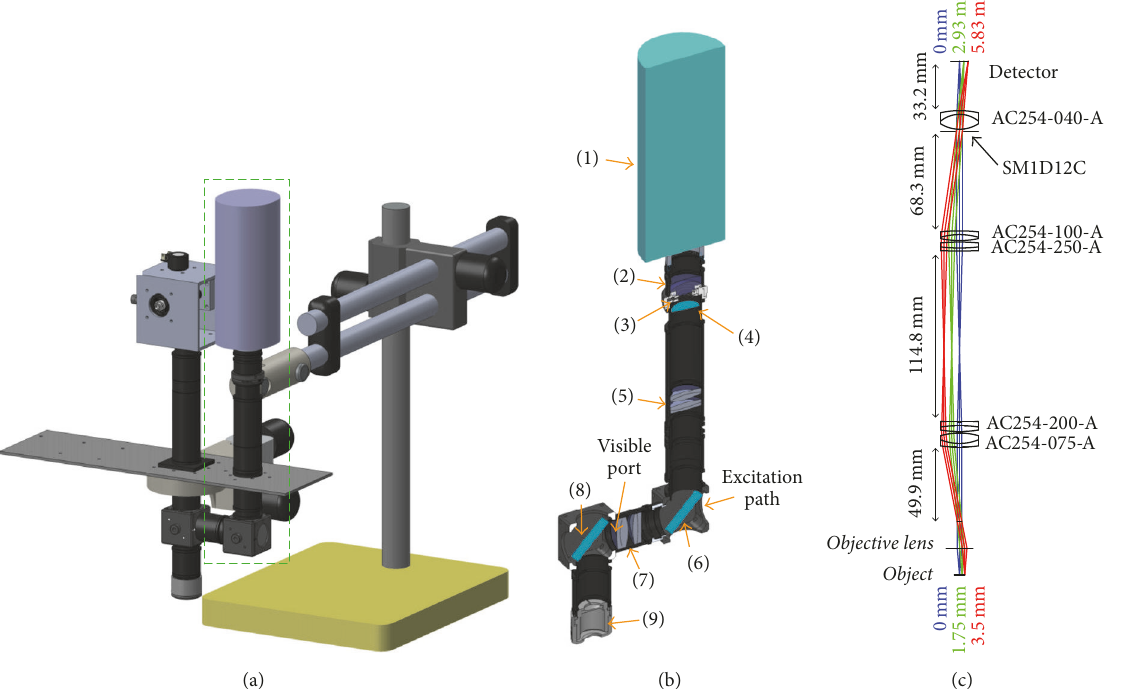
Figure 4: An example of fluorescence imaging integrated with the OCT sample arm. The system uses the same objectives for OCT and fluorescence imaging for simultaneous OCT and fluorescence recordings. (a) The placement of fluorescence imaging path in the OCT sample arm. (b) The SOLIDWORKS design of the fluorescence imaging path. (c) The schematic of the optical design of the path. The fluorescence imaging path uses two semi-Pl¨ossl lenses to image the back-focal plane of the objective to the entrance pupil of an imaging lens. There is an adjustable iris in this path to adjust the aperture diameter of the imaging system. This is helpful to reduce the aberration in the optical path and improve the imaging resolution. (1) Fluorescence camera (EXi Aqua, QImaging, BC, Canada), (2) adjustable iris (SM1D12CZ, Thorlabs, NJ, USA), (3) imaging lens (AC254-040-A, Thorlabs, NJ, USA), (4) optical filter, (5) semi-Pl¨ossl lens (AC254-100-A + AC254-250-A), (6) visible light dichroic mirror (FF440-520-Di01, Semrock Inc., NY, USA), (7) semi-Pl¨ossl lens (AC254-075-A + AC254-200-A), (8)